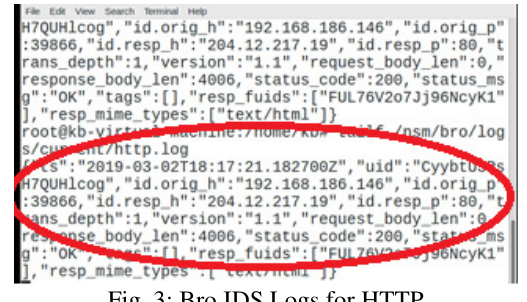
Fig. 3: Bro IDS Logs for